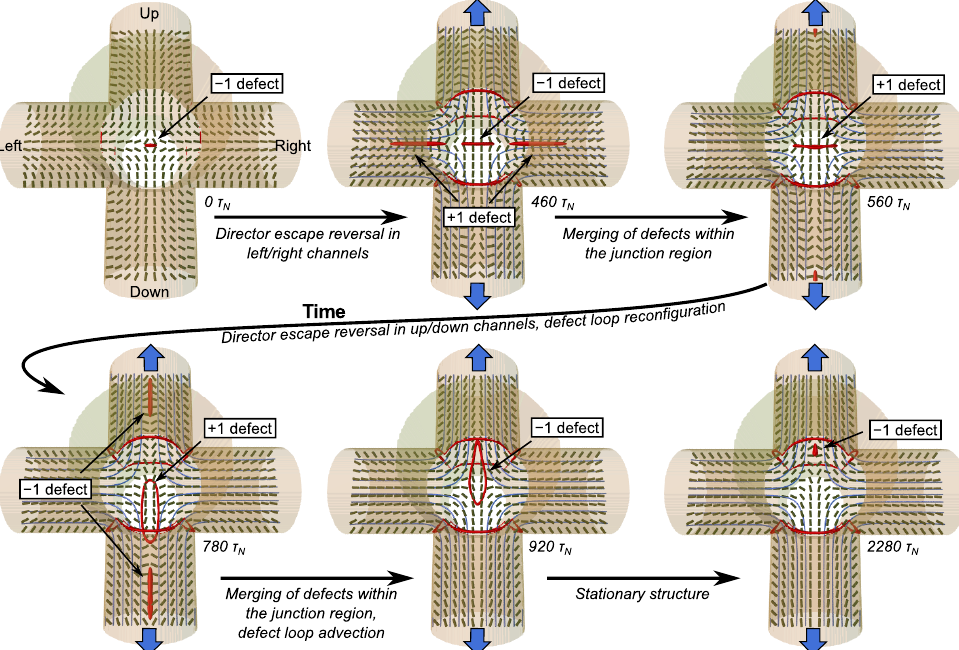
Figure 8. Flow stabilized structures in junctions of nematic-filled channels. Defect dynamics are shown in a junction with extensile flow (i.e., two outlet channels indicated by two blue arrows, and four inlet channels). Initial director profile has 2 outward escaping profiles and 4 inward escaping equilibrium configurations with a − 1 defect at the channel junction center. Flow direction in top and bottom channels is aligned with the direction of director escape. As the nematic undergoes a flow-aligning transition in the left and right channel, a pair of + 1 defects is created at open channel boundaries. The pair coalesces with the previously residing − 1 defect, forming a + 1 defect and, thus, preserving the bulk topological charge. Similarly, undergoing a flow alignment transition, − 1 defects are created in the up and in the down channel. The defects interact and form a stationary state, consisting of a single − 1 bulk defect, which is displaced from the center of the junction in the direction of one of the outgoing flows. Time is measured in units of nematic characteristic time scale 2 τ N = ξ N Γ . The image is reprinted and adapted with permission from the reference [146]–Copyright L (2016) Taylor &